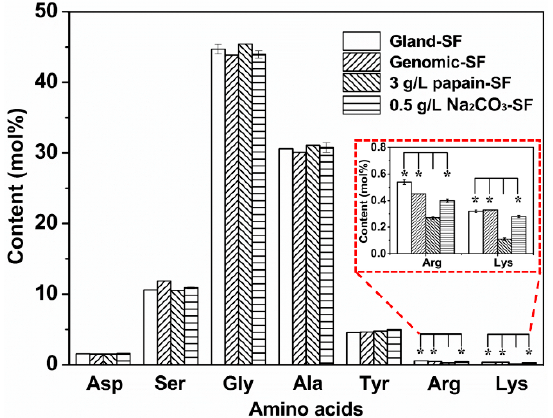
Figure 5. The contents of the main amino acids in silk fibroin obtained by the different methods. * Indicates significant differences compared with 3.0 g/L papain-SF at p < 0.05.